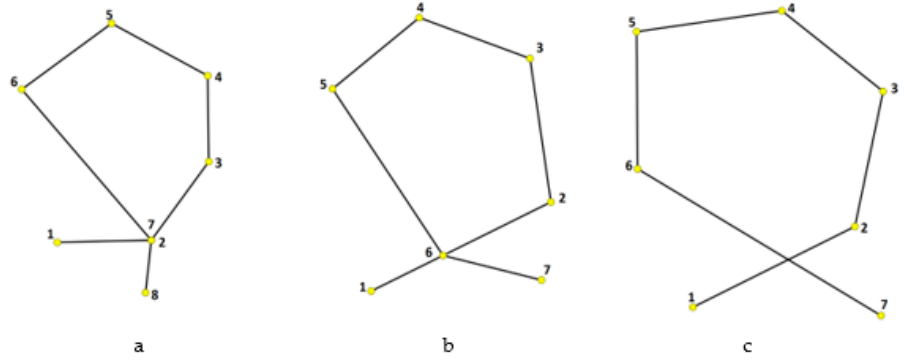
Figure 12. Three modes of intersection in self-intersection trajectories. ( a ) Point to Point Intersection; ( b ) Edge to Point Intersection; ( c ) Edge to Edge Intersection.